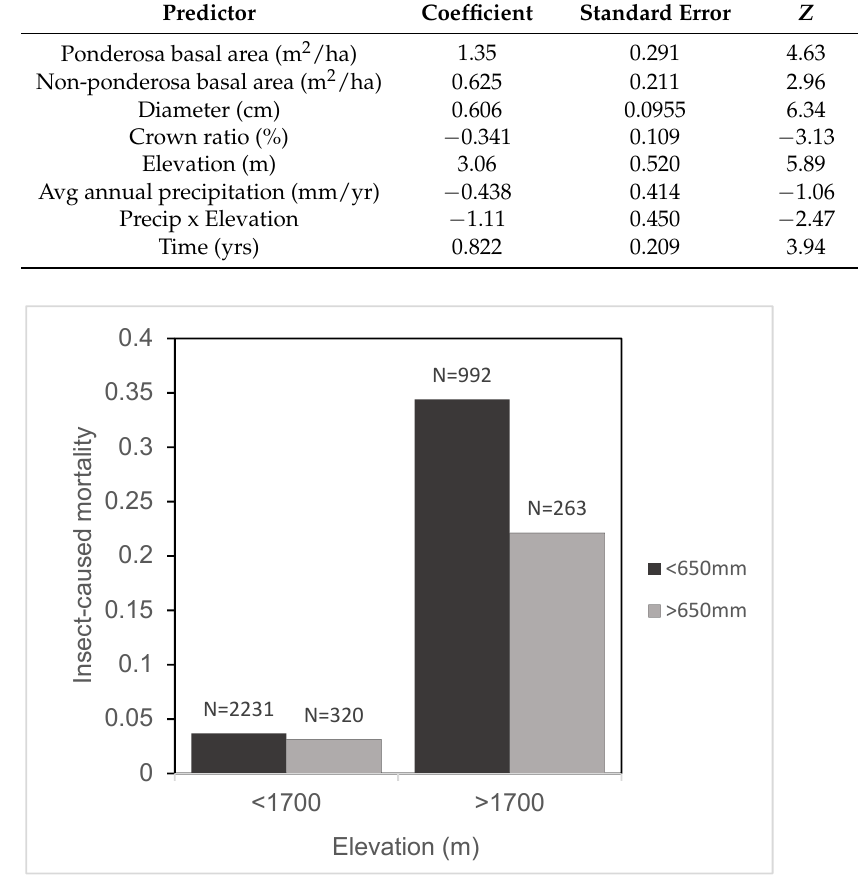
Figure 4. Proportion mortality at high and low elevation, split by precipitation. Higher elevations were associated with higher mortality ( p < 0.001), but this effect was reduced in stands receiving a higher average annual precipitation.